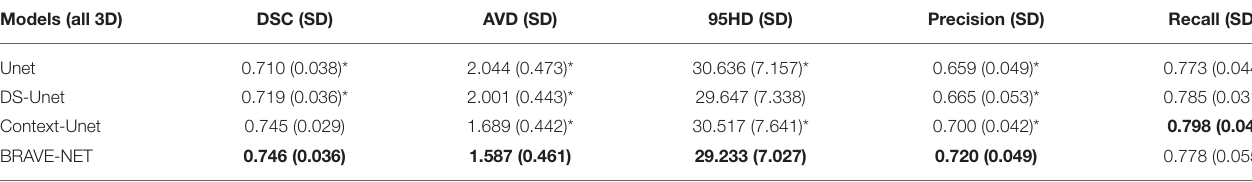
TABLE 4 | Test results on external validation set for all models, average (SD) performance across the 20 patients are shown. Models (all 3D)